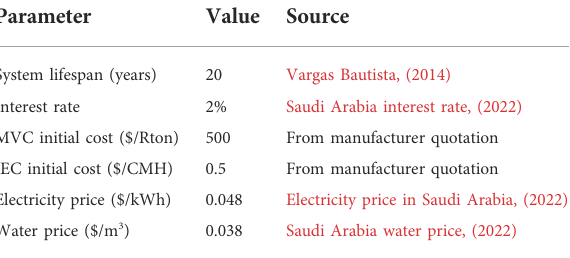
TABLE 2 Economic parameters for IEV-MVC and standalone